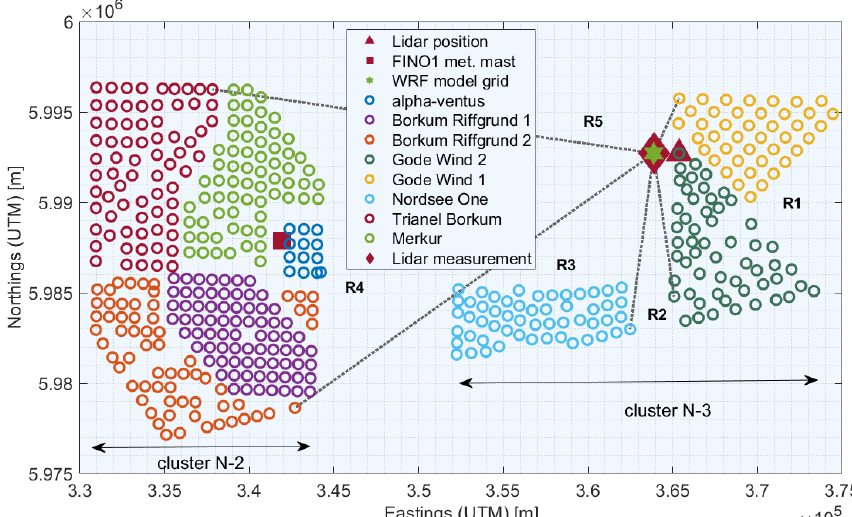
Figure 1. Location of the scanning lidar between the wind farm clusters showing the five sectors (from R1 to R5) into which the data are grouped for the analysis (dashed black lines). The individual wind turbines are represented by circles, and each individual wind farm is shown in a different color. The location of the meteorological mast FINO1 is also indicated (red square). The WRF model grid point investigated in this study is marked with a green star. Lidar system and lidar profile measurement locations are marked with a red triangle and a red diamond, respectively. Coordinates refer to UTM WGS84, zone 32. Table 2. Properties of the wind farms (as of May 2020) surrounding the scanning lidar measurement. The cluster name is defined by